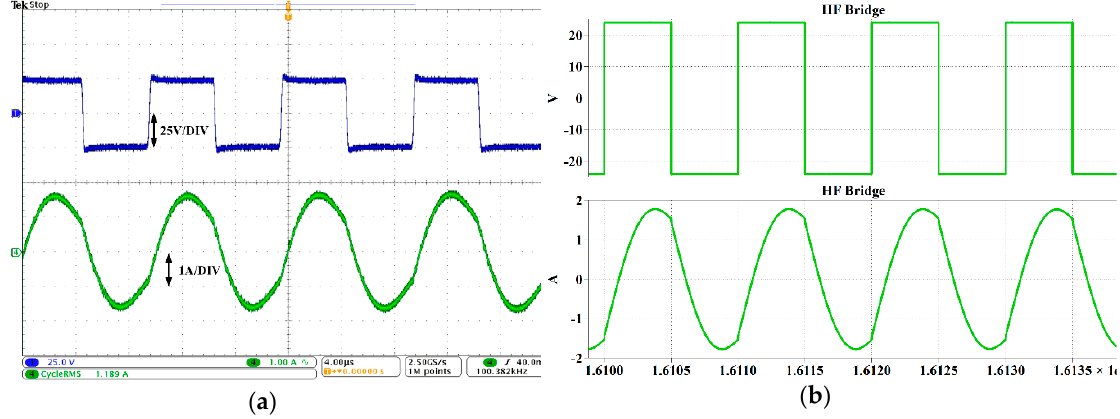
Figure 12. Coil current controller (on the rotor).